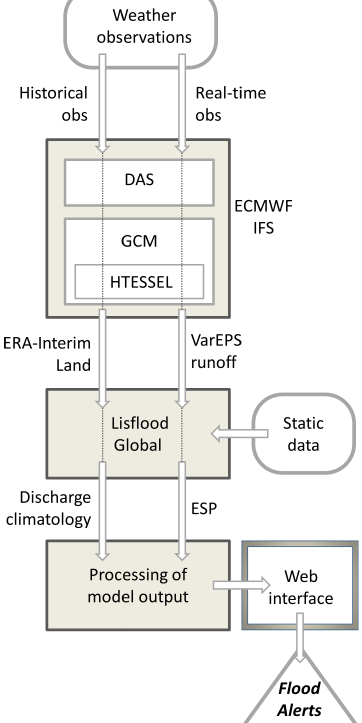
Fig. 1. Overview of the GloFAS